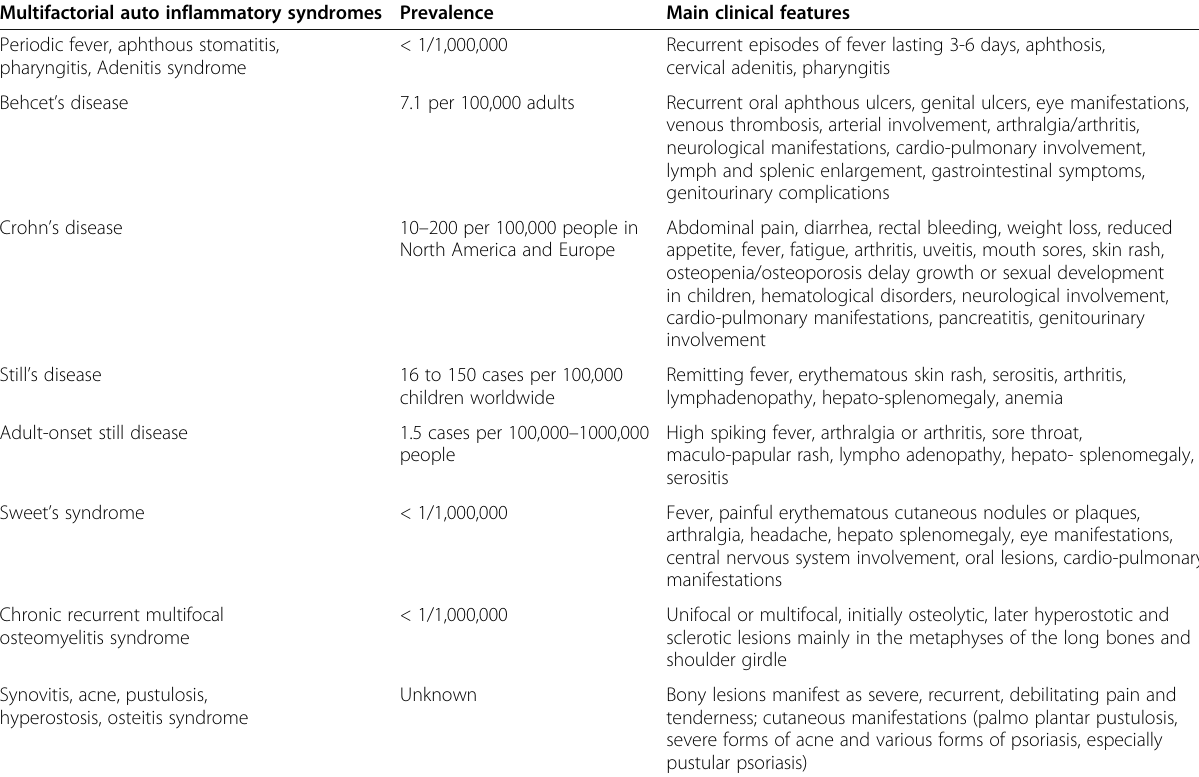
Table 2 Summary of multifactorial autoinflammatory diseases [16] Multifactorial auto inflammatory syndromes Prevalence Main clinical